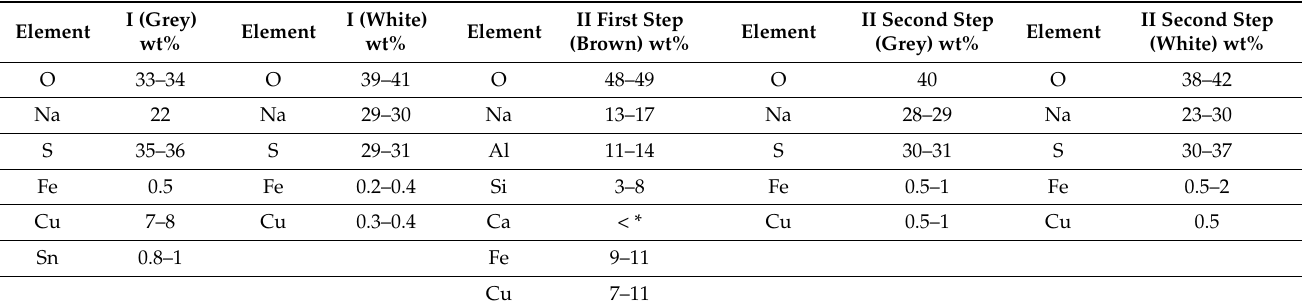
Table 3. Content of elements in the solid phases after alkalization of the post-leaching solutions to pH = 3 (SEM/EDS method).